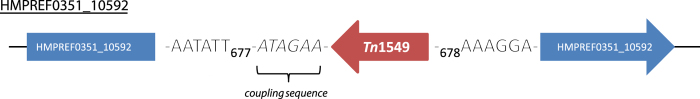
Schematic representation of Tn1549 insertion into the major insertion site HMPREF0351_10592.Insertion and orientation of Tn1549 into HMPREF0351_10592 is depicted alongside six nucleotides framing the specific insertion site. Enumeration of nucleotides is according to the coding sequence of HMPREF0351_10592. The coupling sequence represents nucleotides which were co-transferred from the initial donor strain.